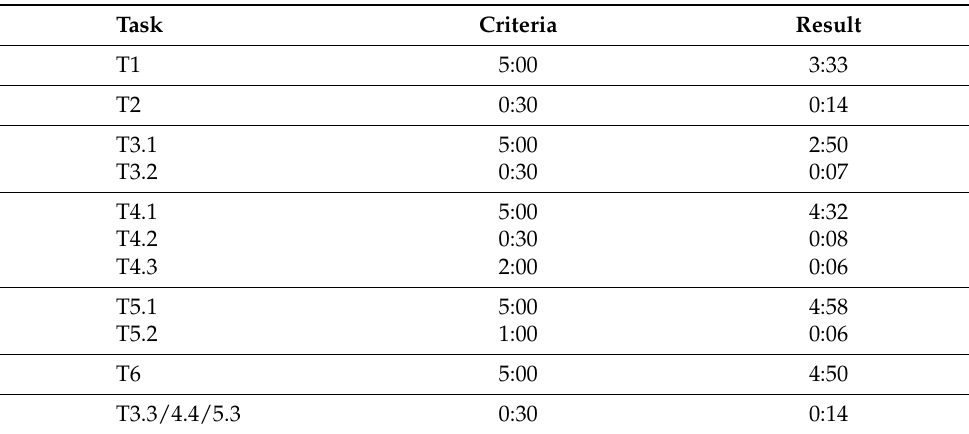
Table 7. Average time (m:ss) to complete